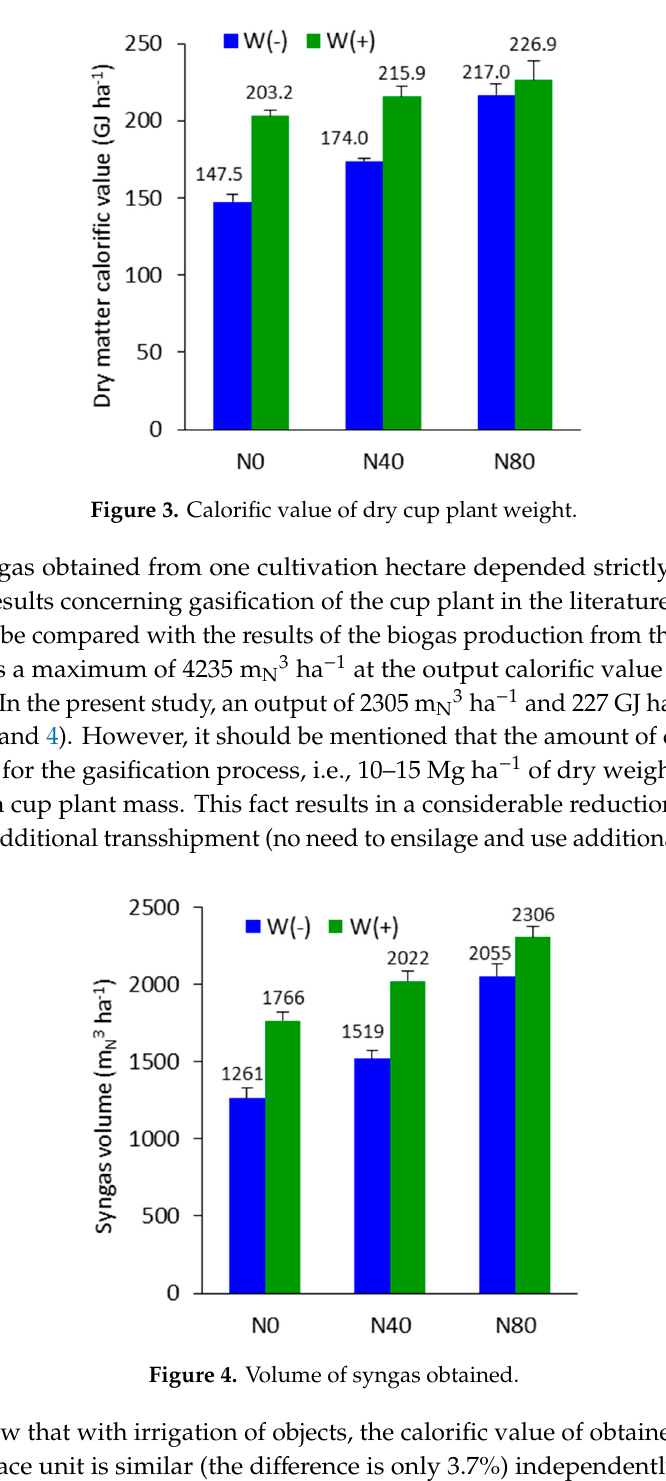
Figure 4. Volume of syngas obtained.